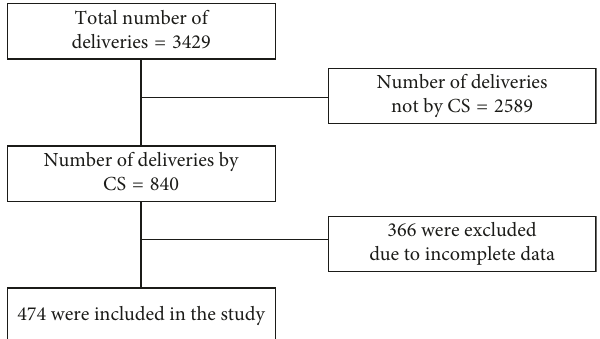
Figure 1: Schematic presentation of sampling procedure at selected health institutions, July 2015–June 2016 ( n �